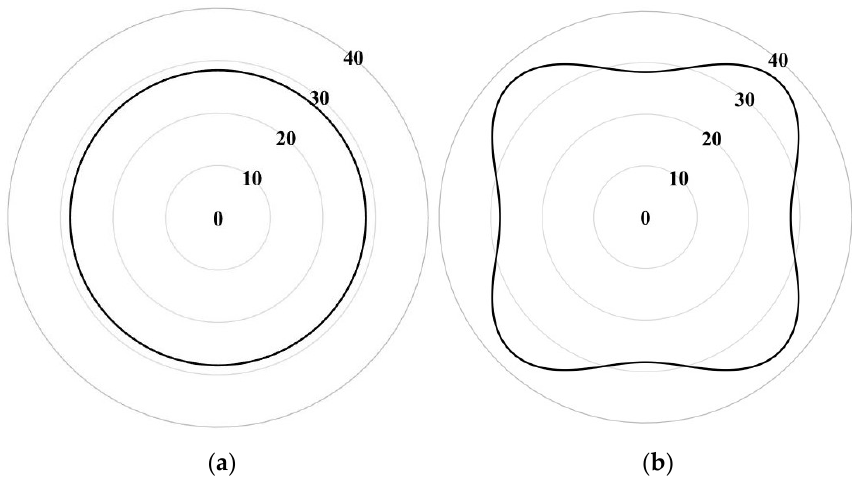
Figure 4. Three-dimensional surface representation of (a) maximum shear modulus and ( b ) mini- mum shear modulus of Ag 9 In 4 .